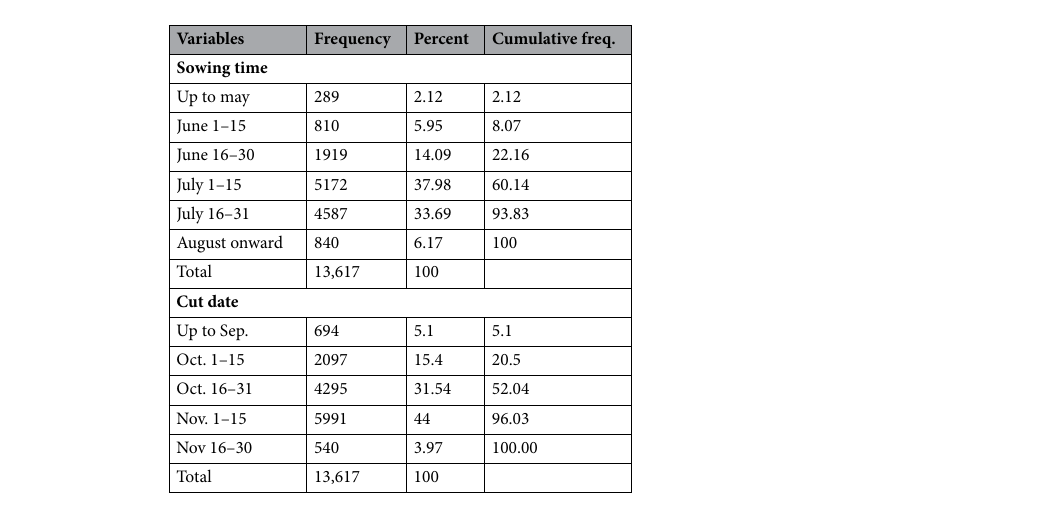
Table 2. Frequency distribution of categorical variables for